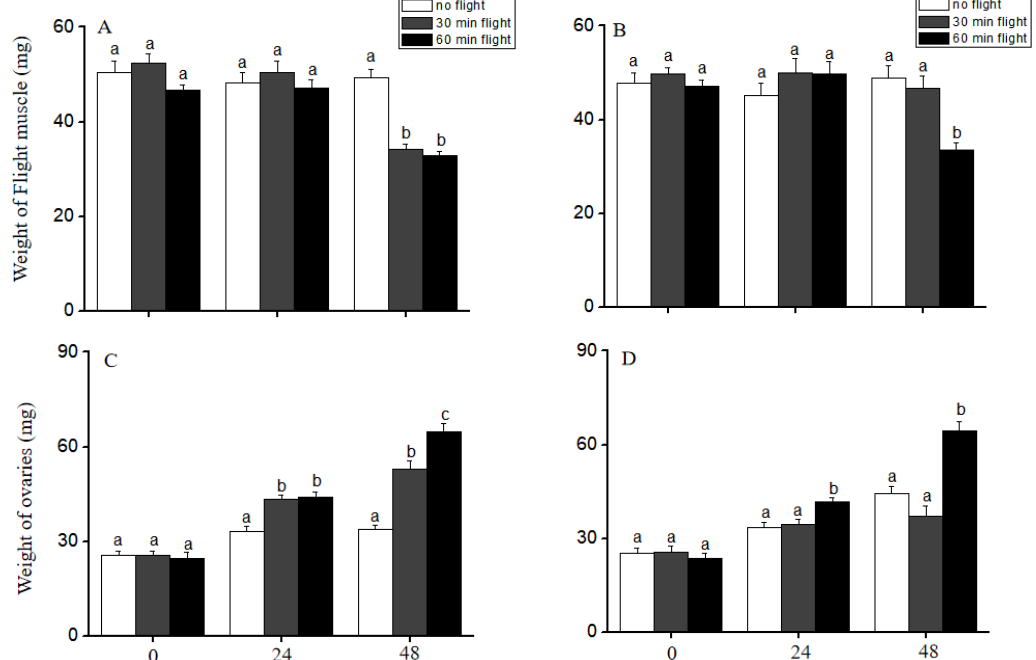
Figure 3. Effect of flight of 30 or 60 min on flight muscle and ovarian development in short-fliers ( A , C ) or long-fliers ( B , D ) of V . aspersus . Different letters indicate a significant difference between groups by ANOVA, post-hoc multiple comparisons of the means, p < 0.05, n = 20 for each group.